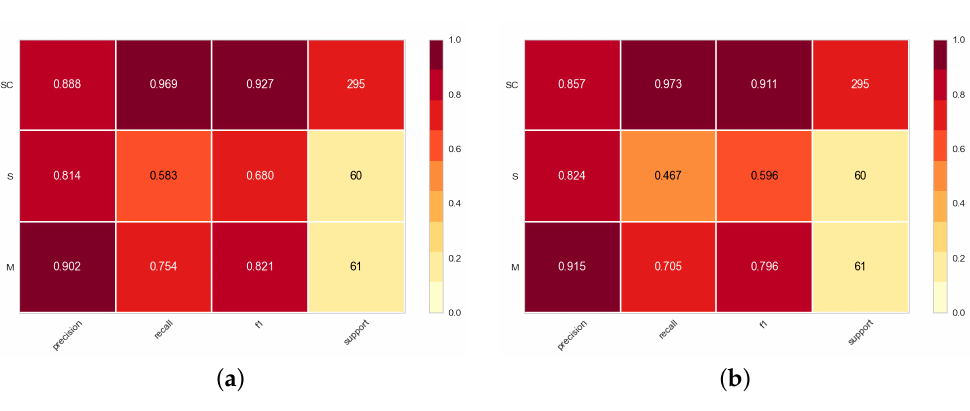
Figure 4. Classification reports of each lithology class for XGBoost ( a ) and RF ( b ).